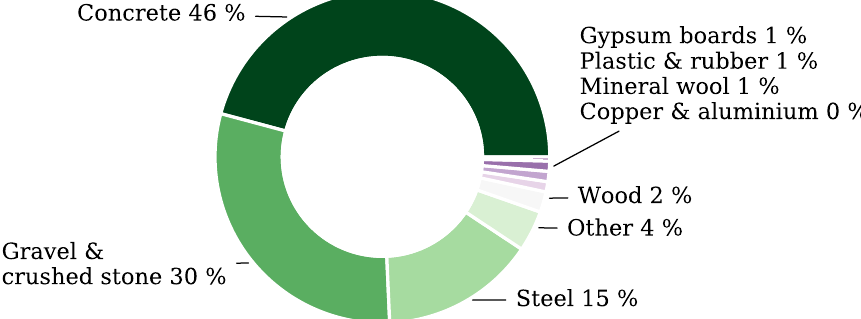
Figure 1. Distribution of mass for different material categories in the